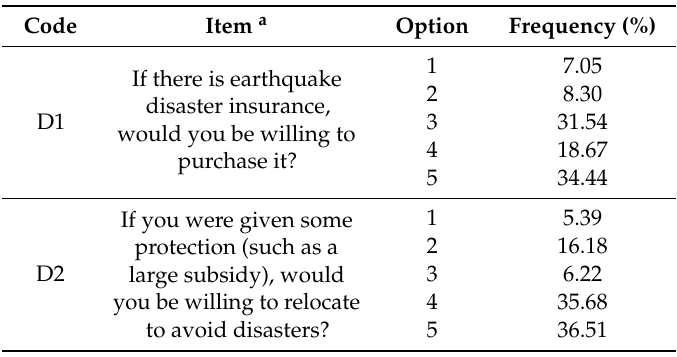
Table 6. The frequency distribution table of rural households’ willingness to purchase insurance and willingness to avoid disasters and